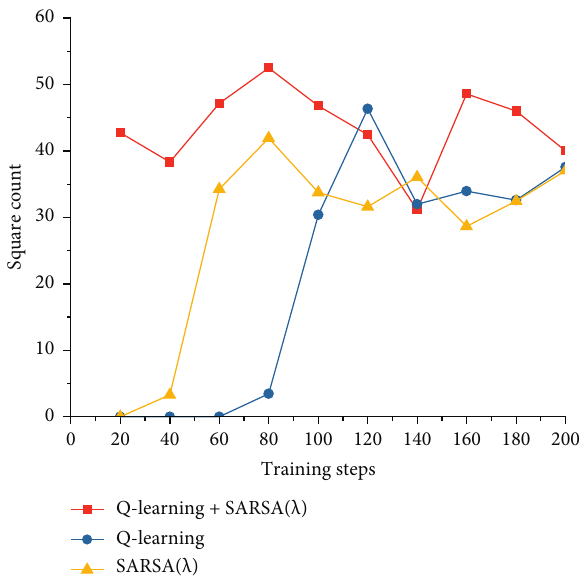
Figure 5: Number of squares employing different algorithms.